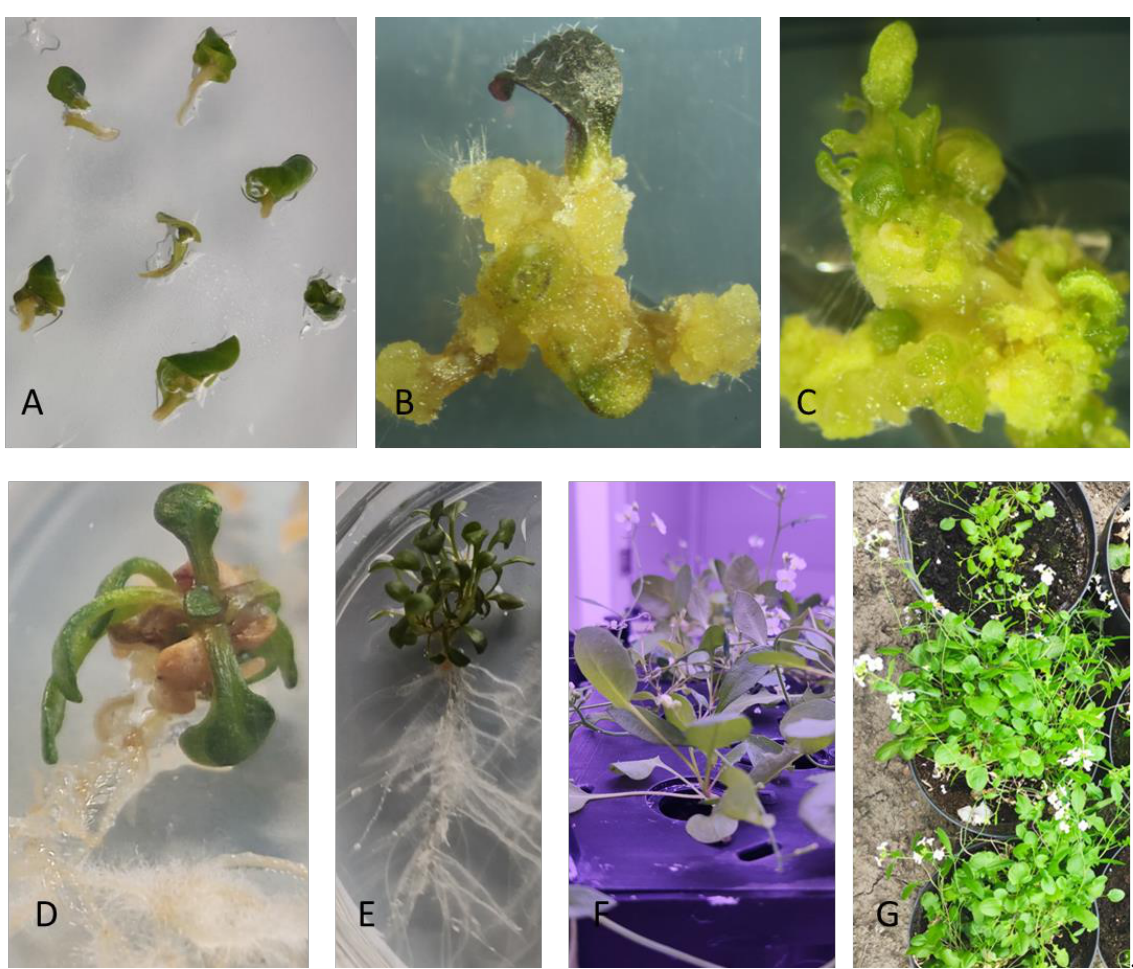
Figure 1. Successive stages of obtaining Arabidopsis arenosa regenerants. Fragments of seedlings laid out on the callus induction medium ( A ), callus tissue derived from the hypocotyl with cotyledons on the ½ MS medium supplemented with 2 mg L −1 2,4-D and 2 mg L −1 BAP ( B ), adventitious shoots on the ½ MS medium supplemented with 1 mg L −1 TDZ ( C ), rooted plant on the ½ MS after 10 weeks on a rooting medium ( D ), regenerated plant on ½ MS ready for transfer to hydroponics ( E ), flowering plants maintained in a hydroponic culture ( F ), and acclimatized to outdoor conditions ( G ). 2,4-D — 2,4-Dichlorophenoxyacetic acid; BAP — 6-Benzylaminopurine; MS — Murashige and Skoog medium; TDZ — Thidiazuron.